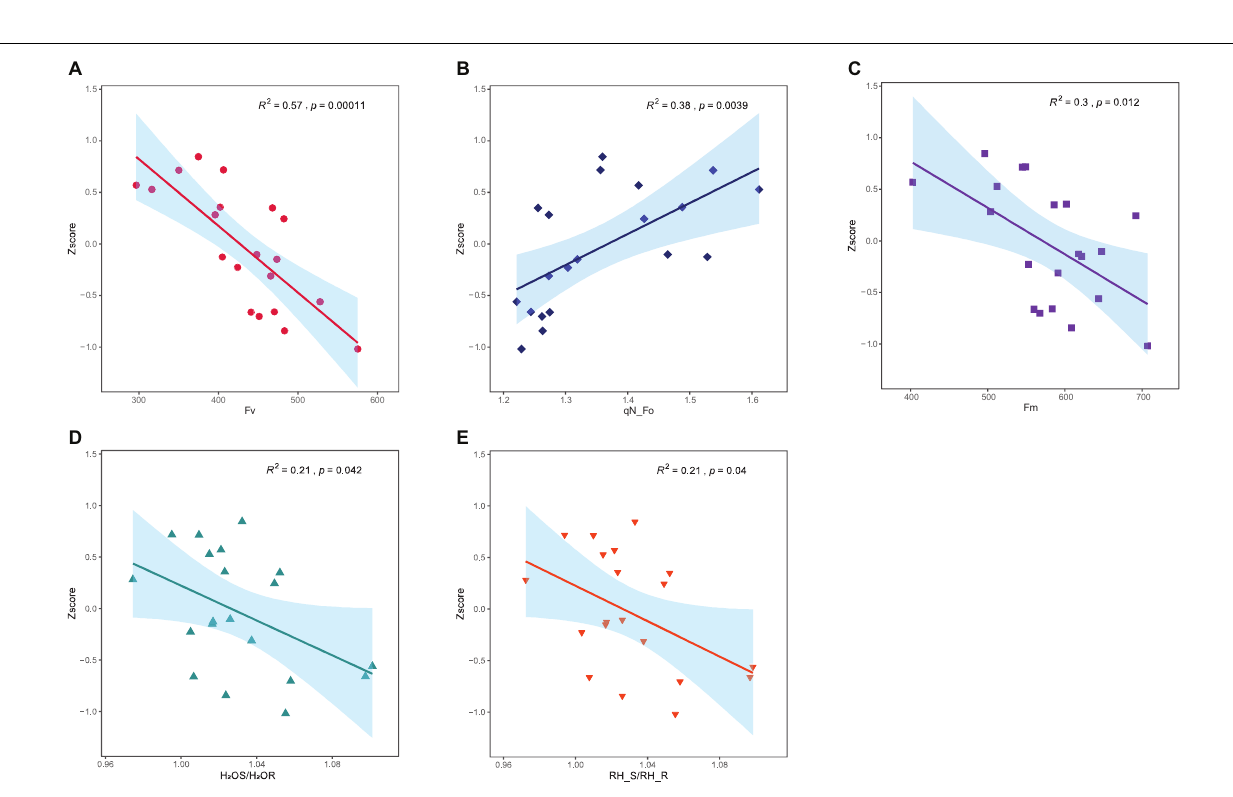
Frontiers in Plant Science |